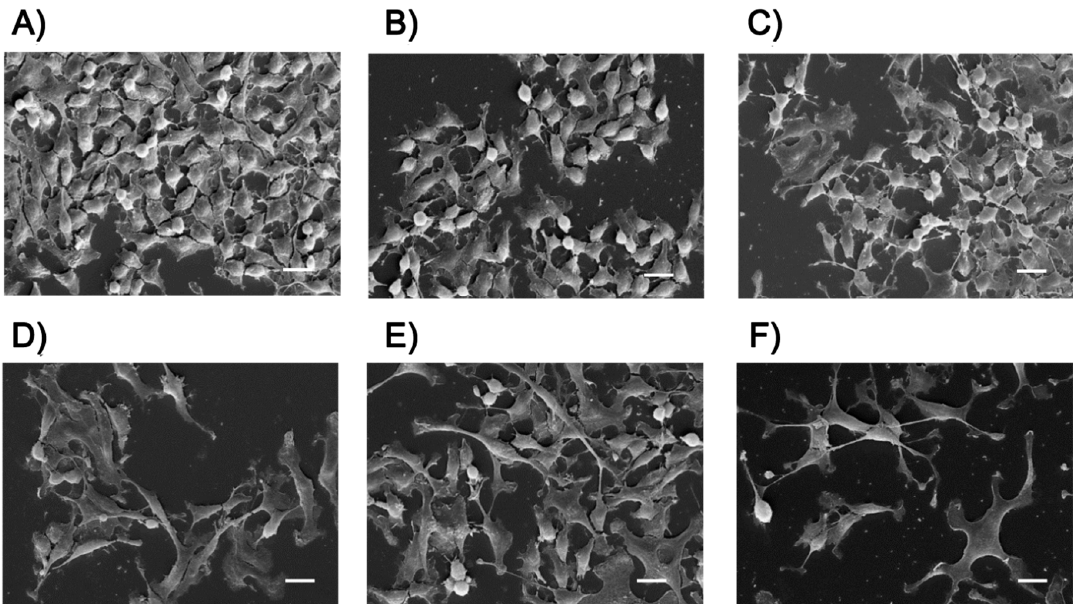
Figure 9. LoVo cells visualized by scanning electron microscopy. Control cells ( A ) in the presence of FA-PEG@MNPs ( B ) and PEG@MNPs ( C ). The cells after NaBu treatment ( D ) and the combined action of FA-PEG@MNPs ( E ) and PEG@MNPs ( F ) with NaBu. Scale bar 10 µ m.